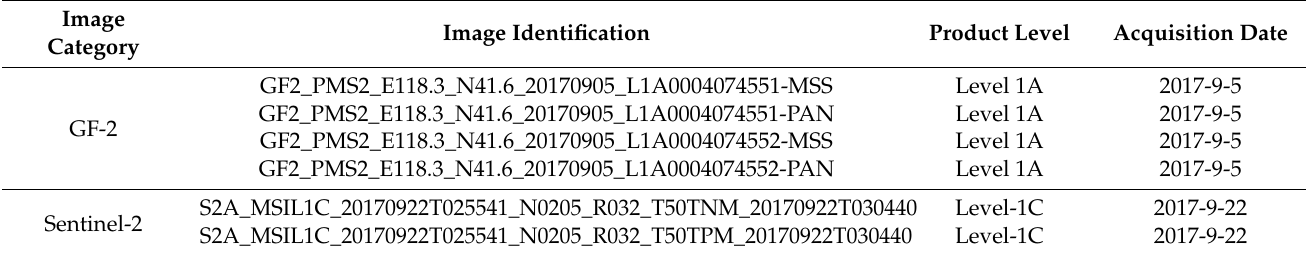
Table 2. Parameter information for Gapfen-2 (GF-2) and Sentinel-2 remote sensing images.